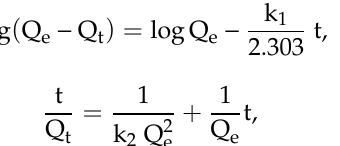
Figure 12. SEM image of ERH rice husk.